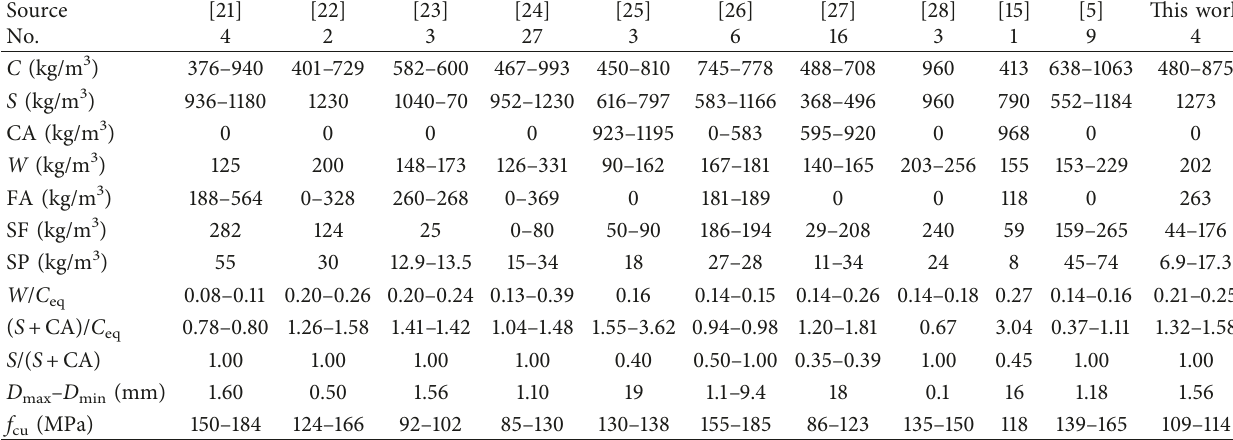
Table 4: Details of data and their